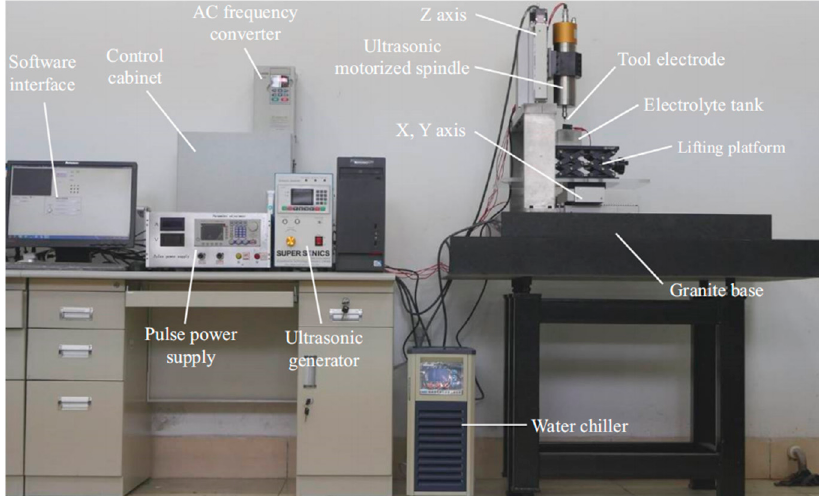
Figure 4. Picture of the physical experimental platform.